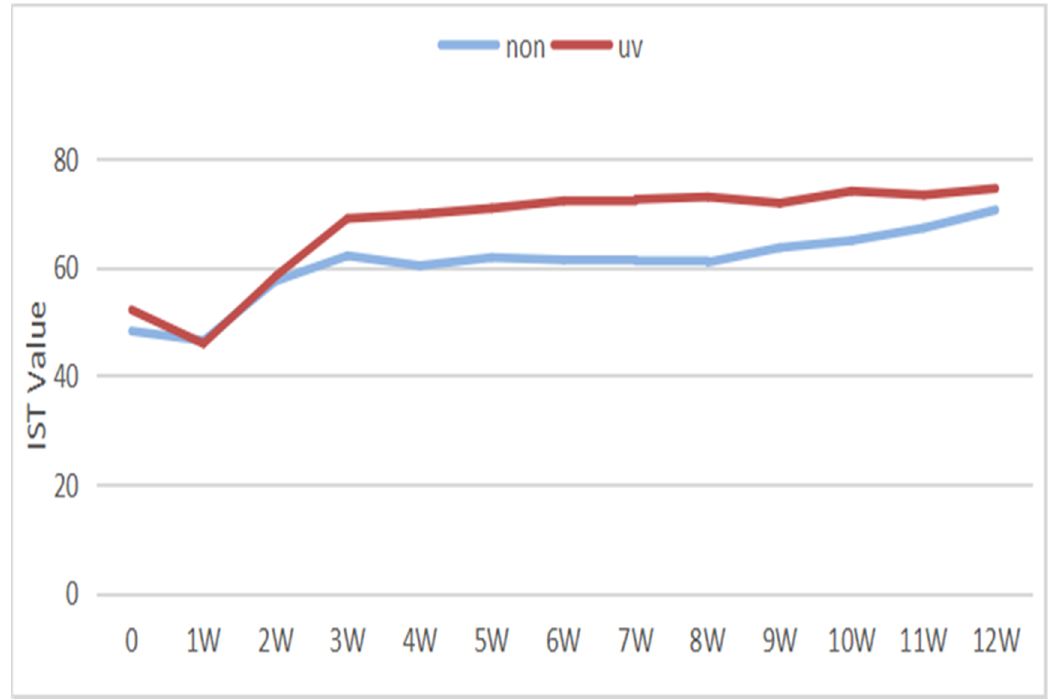
Figure 5. Comparative Results of weekly measured Implant Stability Test (IST) values.